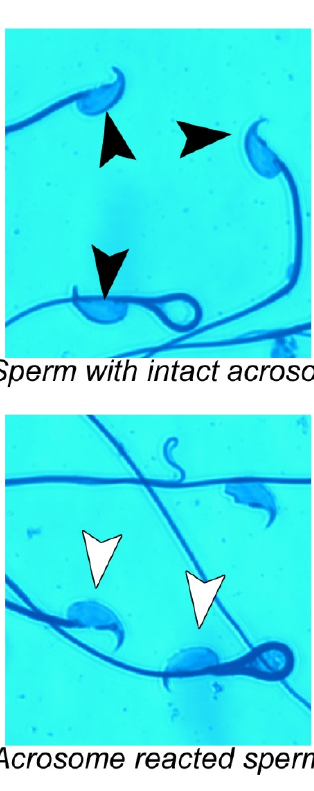
Figure 1. The mutant H48Q-PLA2G10 does not trigger an acrosome reaction contrary to WT-PLA2G10. Sperm from C67BL/6 males were capacitated for 45 min in M16 medium containing 2% BSA, capacitated sperm were treated for 10 min with either 200 nM of WT-PLA2G10 or H48Q-PLA2G10 (noted H48Q), and acrosome reacted sperm were scored using a blue Coomassie technique. In non-acrosome reacted sperm, a dark blue band is present (black arrow head), whereas this band is absent in acrosome reacted sperm (white arrow heads) n = 7. n represents the number of biological replicates and for each replicate, more than 100 sperm were assessed per condition. The statistical difference in the mean was assessed using the t -test. p -value, as indicated. NS, not significantly different.